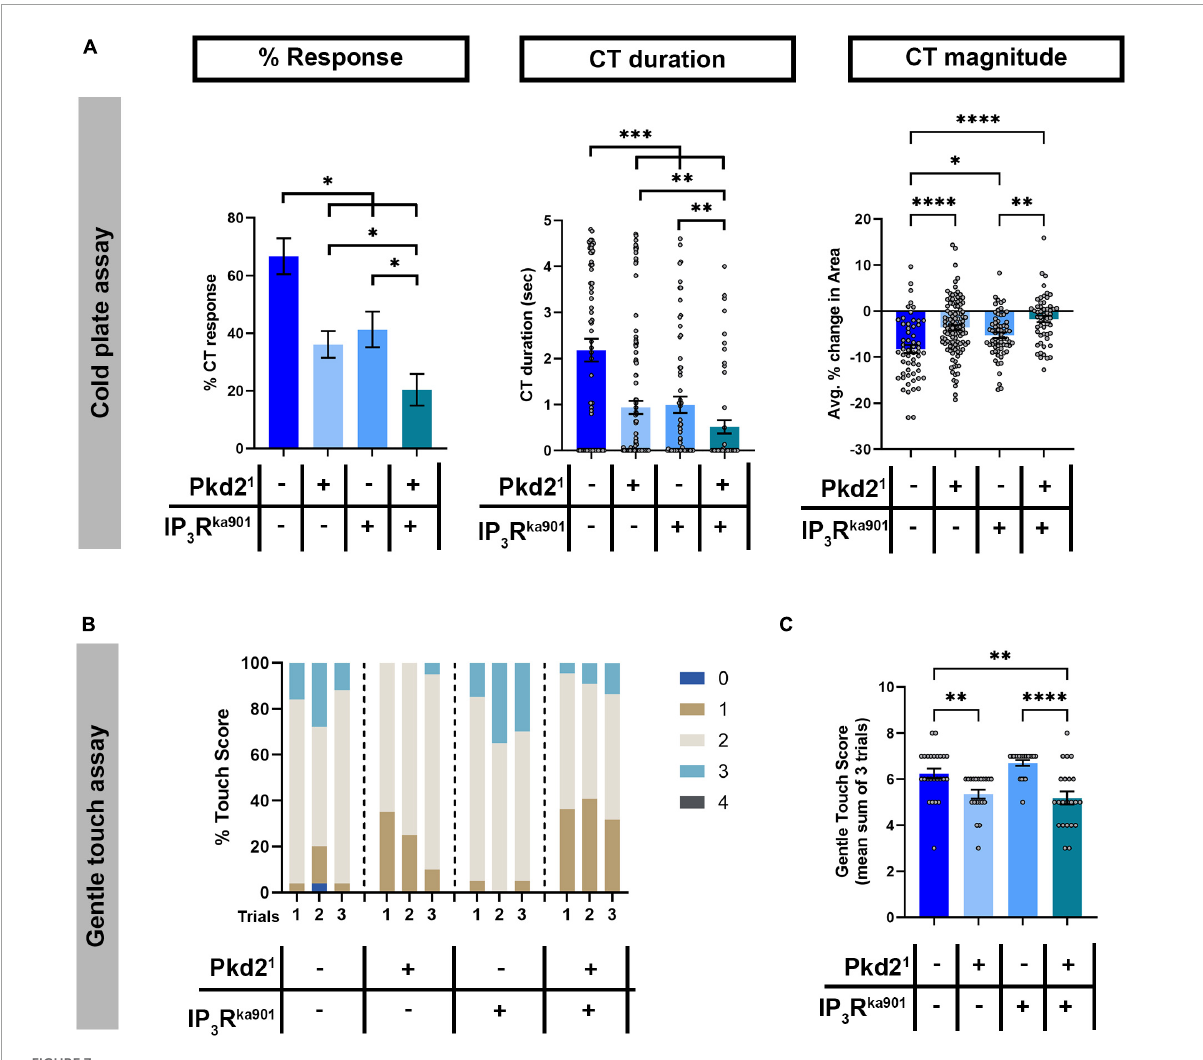
FIGURE7 Pkd2 and IP 3 R genetically interact in cold nociception, but not innocuous mechanosensation. (A) Cold plate analysis of Drosophila larvae mutant for either/both Pkd2 1 and IP 3 R ka 901 . We report %CT (left), CT duration in seconds (middle), CT magnitude (right). N Average = 70. (B,C) Gentle touch assay of Drosophila larvae mutant for either/both Pkd2 1 and IP 3 R ka 901 . (B) Proportion of each touch score per trial for each genotype. (C) Average total touch scores for each larva per genotype. N Average = 22. Statistics: Kruskal–Wallis with Benjamini, Krieger, and Yekutieli for multiple comparisons. (A–C) Genotypes include: w1118 , Pkd2 1 /+ , and IP 3 R ka 901 /+ , Pkd2 1 /IP 3 R ka 901 . Significant differences indicated via asterisks, where ∗ p < 0.05, ∗∗ p < 0.01, ∗∗∗ p < 0.001, and ∗∗∗∗ p <